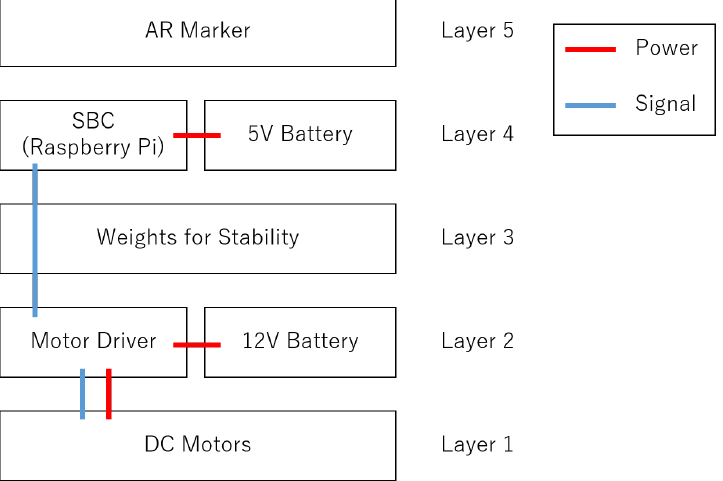
Figure 3. Robot hardware configuration: The robot built for this experiment consists of five layers. The bot- tom two layers are the drive unit. The center is a weight for stabilization. The layer above that contains the control computer for path following. There is an AR marker at the top for position measurement.